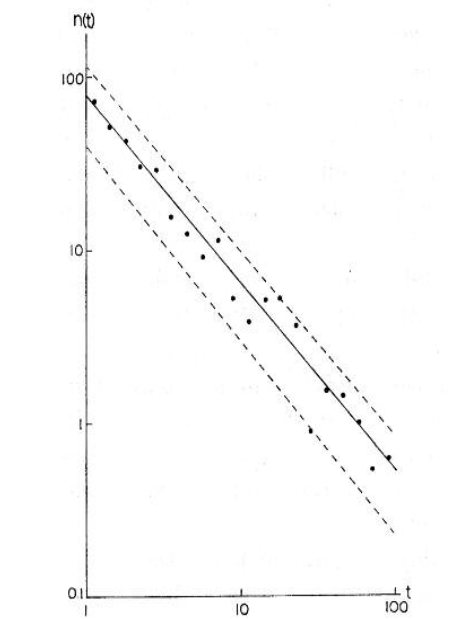
Figure 1. Time distribution of aftershocks: Alaska